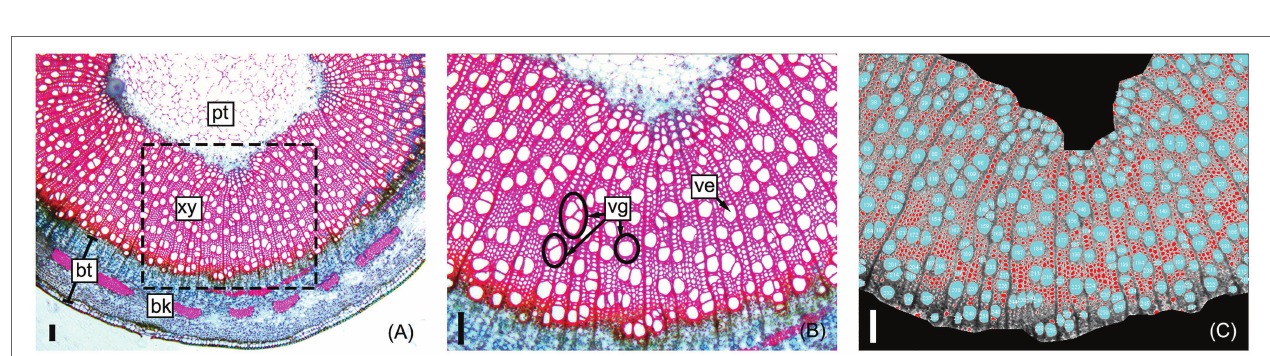
FIGURE 1 | Insertion and deletion (indel) coverage across the poplar genome for genotypes included in this study. Based on the indel size and location in the 201 genotypes chosen for this study, 95% of the genome is covered by at least one indel.